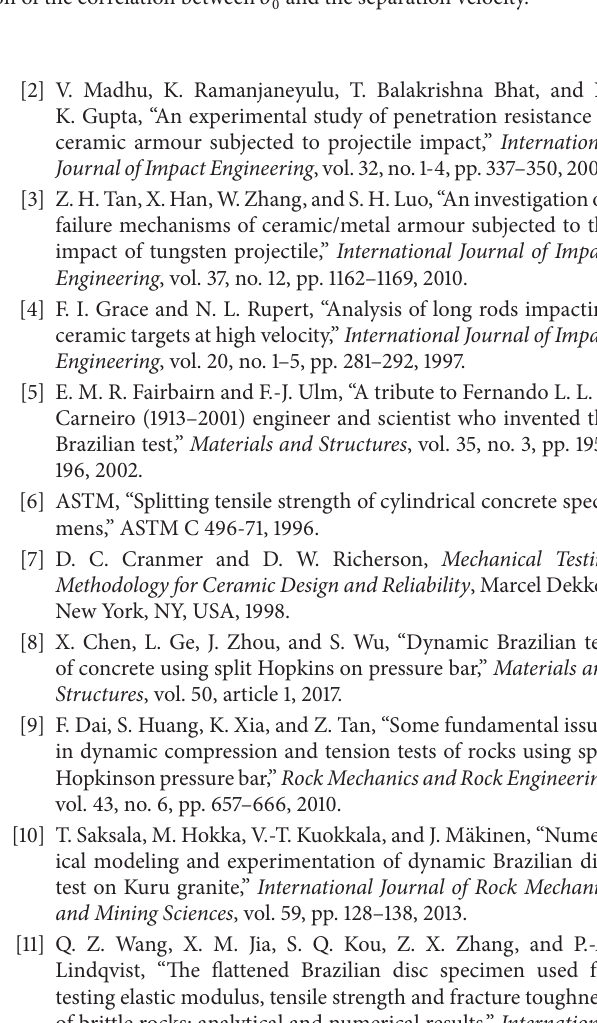
Figure 8: Opening displacement measurement and evaluation of the correlation between 𝜎 0 and the separation